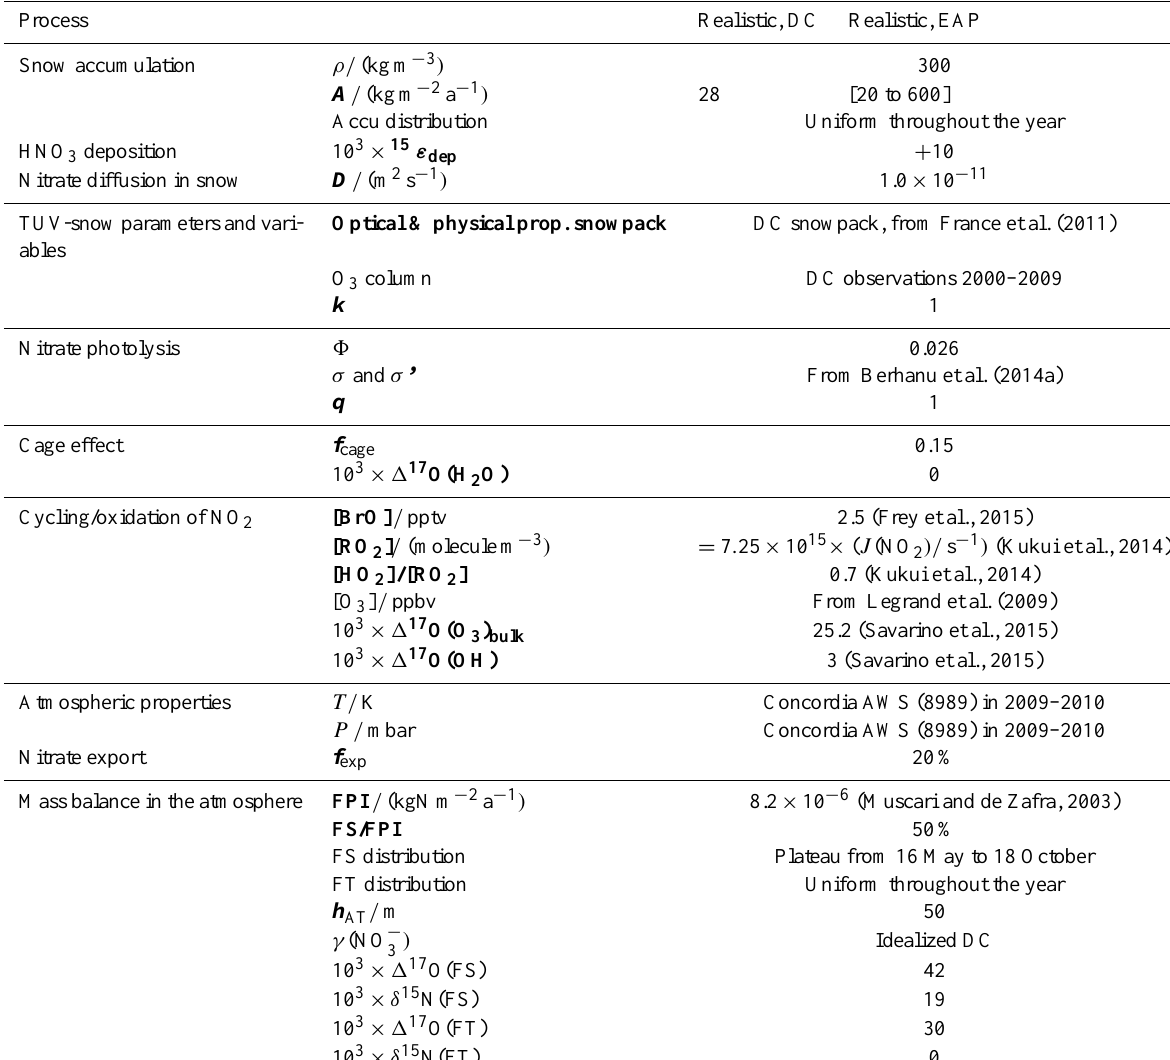
Table 3. Parameters and variables used for the realistic simulation of TRANSITS. Input time variables and fixed parameters are written in